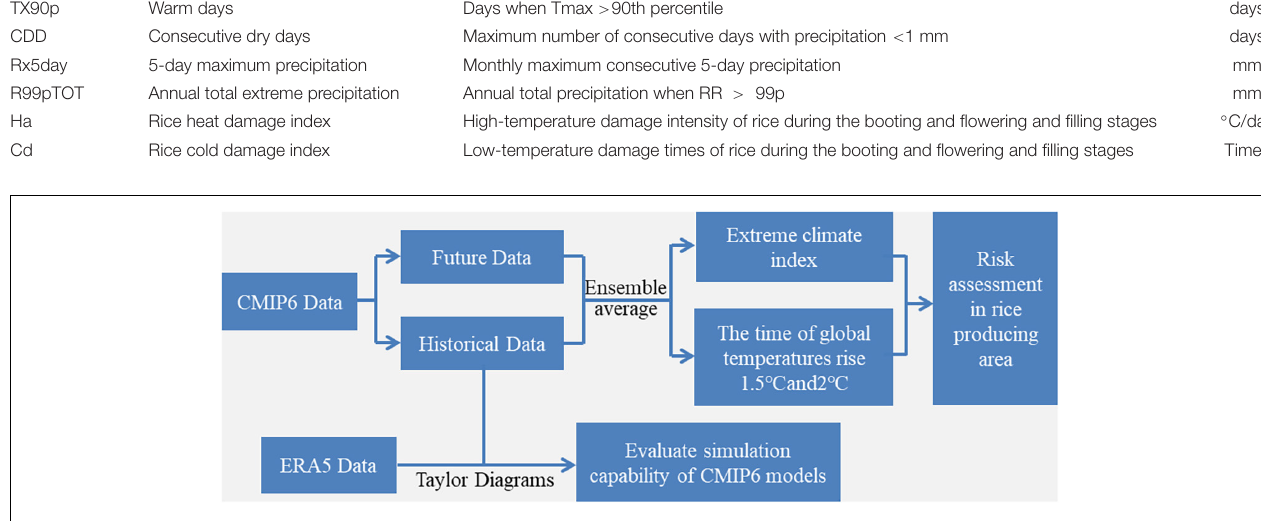
FIGURE 2 | Flow chart of changes in extreme climate events in rice-growing regions under different warming scenarios in China.